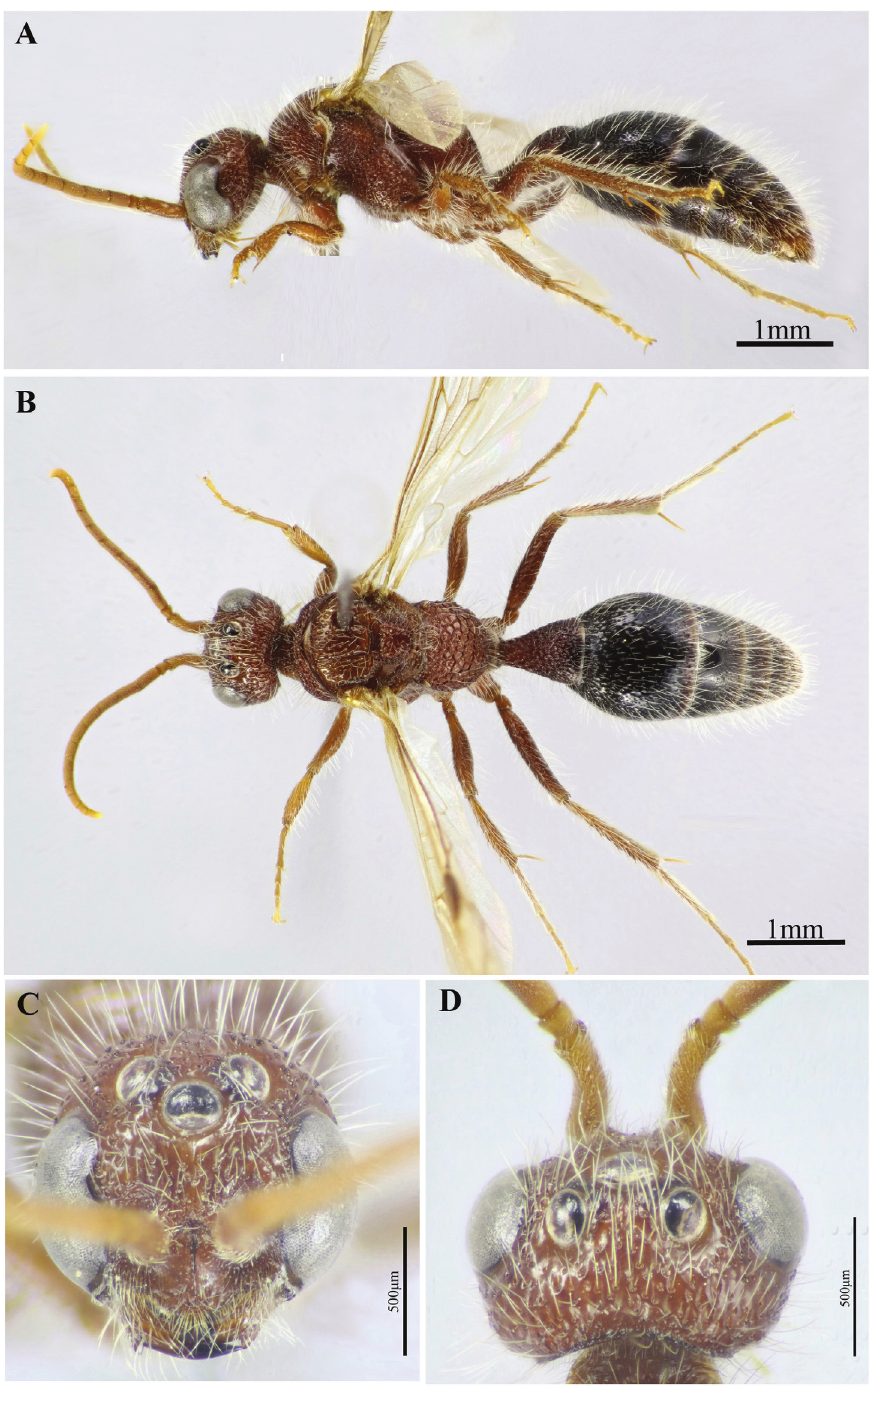
Figure 11. Pseudophotopsis dhofarensis sp. nov. (Male) A, B habitus, lateral and dorsal views, respectively C head, frontal view D head, antennal scape and pedicel, dorsal